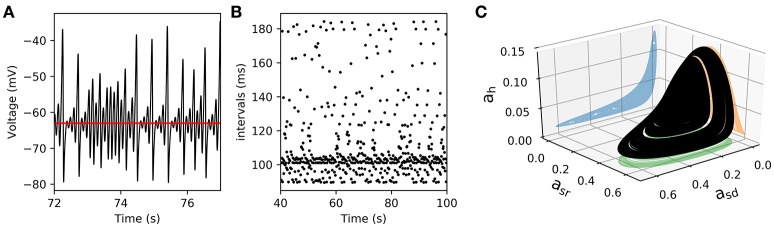
Chaotic behavior in the slow subsystem of the model. (A) Voltage trajectory of the model with gd = gr = 0, and gsd=0.222(mS/cm2). The rest of parameters are as given in Table 1. The red line depicts Veq, the value of V at the unstable singular point associated to the attractor. (B), Time intervals between successive crossings (with positive slope) of the Veq value. (C), 3D plot of a strange attractor in the asd, asr, ah sub-space (black trace). The 2-D projections onto the corresponding planes are shown in color.